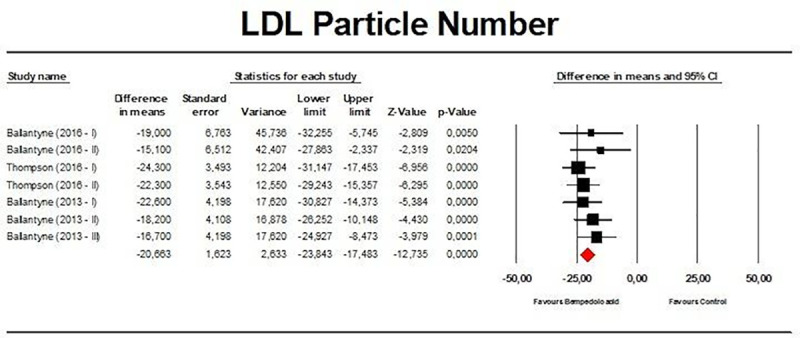
Forest plot displaying mean difference and 95% confidence intervals for the effect of bempedoic acid on plasma levels of low-density lipoprotein (LDL) particle number.